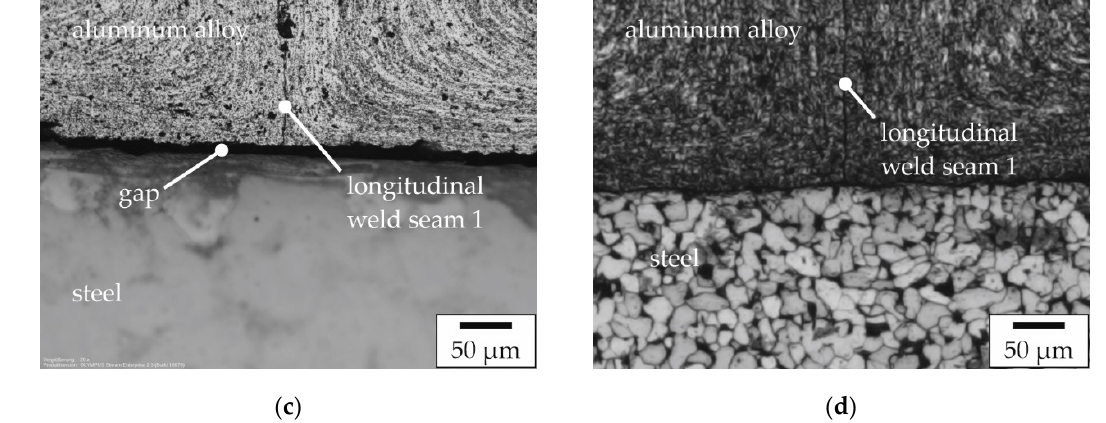
Figure 8. Cross-sections of ( a ) start and ( b ) end of a compound profile made of EN AW 6082 and 20MnCr5 with an extrusion ratio of 11:1; the position of the longitudinal weld seams is highlighted by dotted lines; the outer contour of the steel is highlighted with black dashed lines; the outer contour of the aluminum is highlighted with white dashed lines; with ( c ) detailed image of the bonding area with a gap between the joining partners from the front end of the compound profile; with ( d ) detailed image of the bonding area from the back end of the compound profile; etching: ( a – c ) HF / H 2 SO 4 mixture, ( d ) HNO 3 / Ethanol mixture.